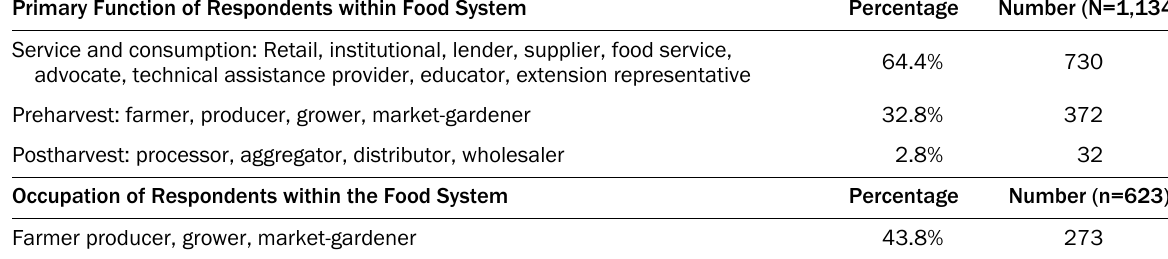
Table 3. Respondents’ Primary Function and Occupation within the Virginia Food System Primary Function of Respondents within Food